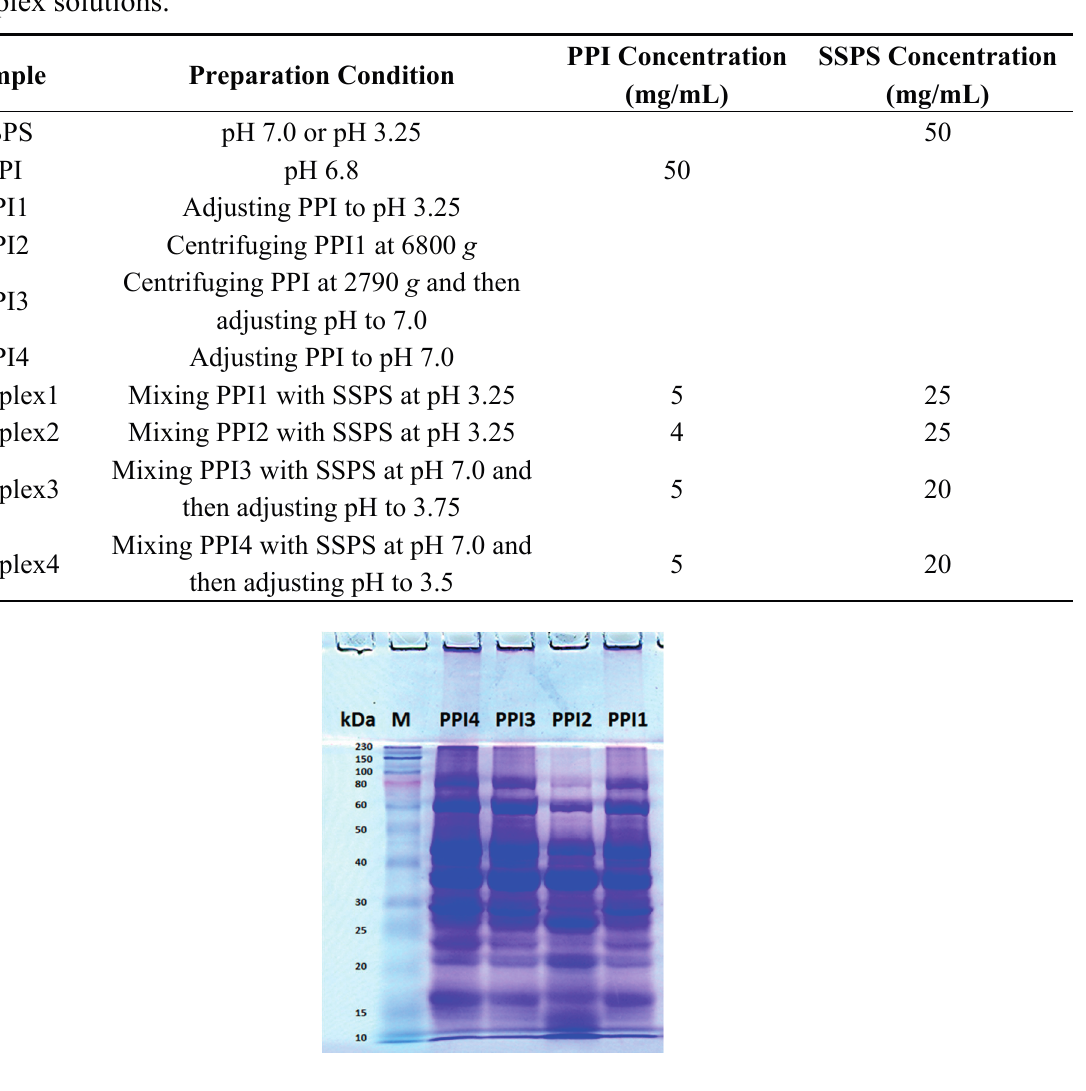
Figure 2. SDS-PAGE analysis of the four PPI solutions under reducing condition. Approximately 0.04 mg PPI was loaded in each